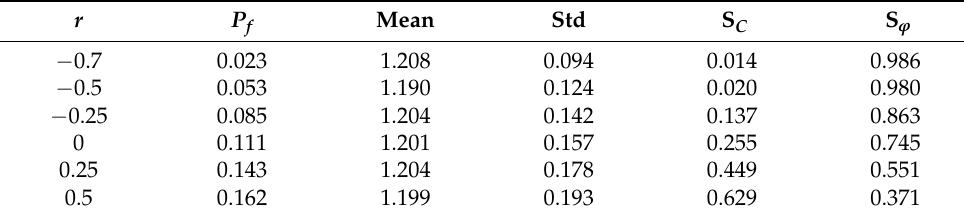
Table 6. Probabilistic results comparison with different values of cross-correlation